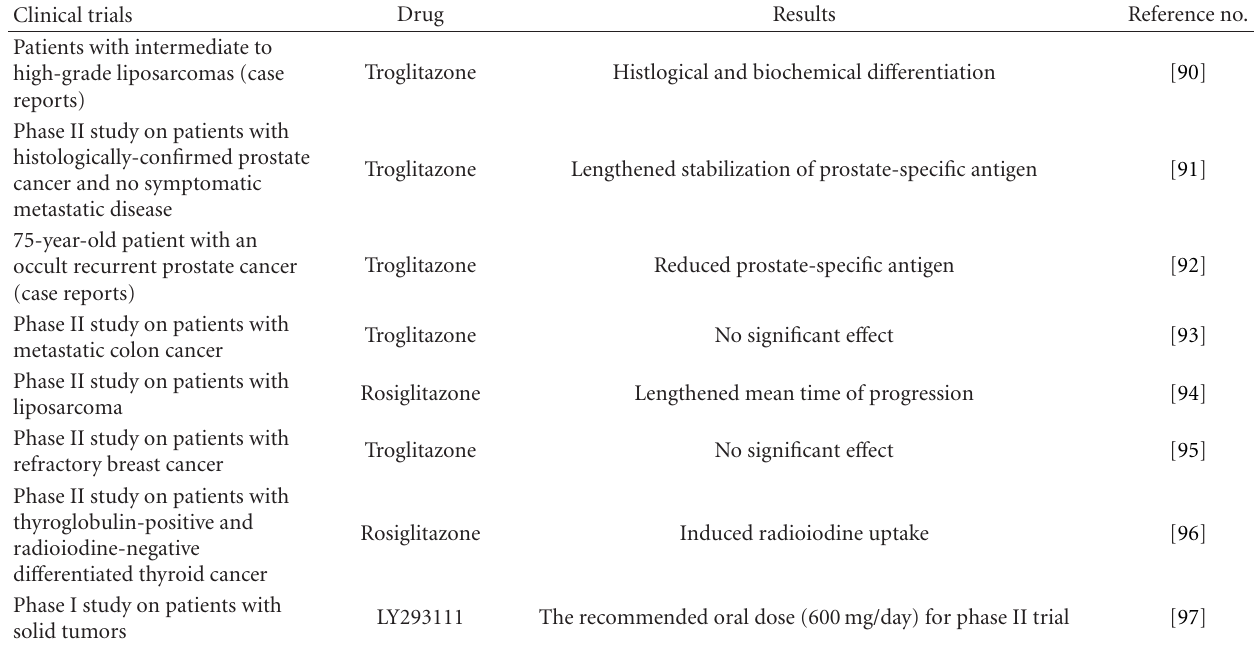
Table 3: Clinical trials on the anticancer e ff ects of PPAR γ